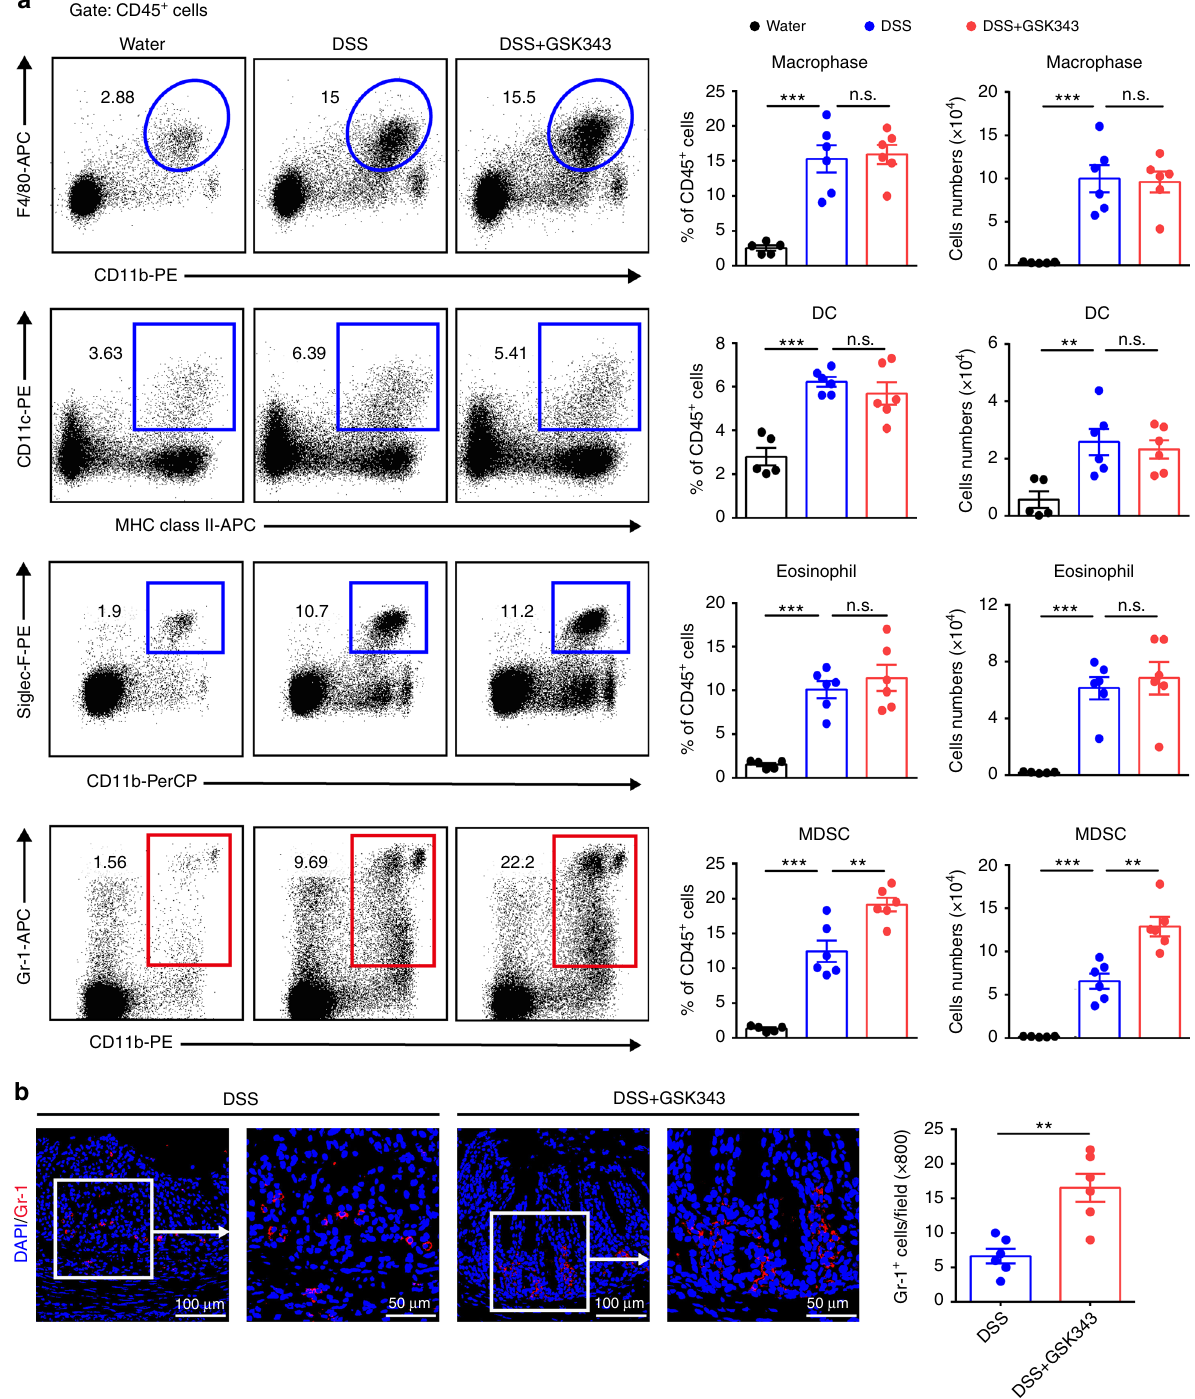
Fig. 3 EZH2 inhibition increases colonic myeloid-derived suppressor cells (MDSCs). C57BL/6 mice were exposed to either 2.5% DSS-containing or regular drinking water alone for 5 days. DSS-treated mice were intravenously injected with either vehicle or GSK343 at days 0 and 3. a At day 5, the representative staining, percentage, and absolute number of macrophages (CD11b + F4/80 + ), dendritic cells (DCs) (major histocompatibility complex (MHC) class II + CD11c + ), eosinophils (Siglec-F + Gr-1 - ), and MDSCs (CD11b + Gr-1 + ) in CD45 + cells of the cLP were determined by fl ow cytometry ( n = 5, Water; n = 6 for both DSS and DSS + GSK343). Dot plots are gated on CD45 + cells. Numbers adjacent to the outlined areas indicate the percentage of the gated population in each group. b The expression of Gr-1 (red) in distal colon tissue sections from DSS-exposed mice treated with vehicle or GSK343 was detected by immuno fl uorescence staining. Magni fi ed views of the marked areas are shown in the adjacent panels. The numbers of Gr-1 + cells per fi eld are enumerated on the right ( n = 6 per group). Throughout, data are representative of three independent experiments. The statistical signi fi cance of differences was determined by one-way analysis of variance followed by Bonferroni post test ( a ) and unpaired two-tailed Student ’ s t -test ( b ). * P < 0.05, ** P < 0.01, *** P < 0.001, n.s. = not signi fi cant. Error bars indicate means ± SEM. Source data are provided as a Source Data fi